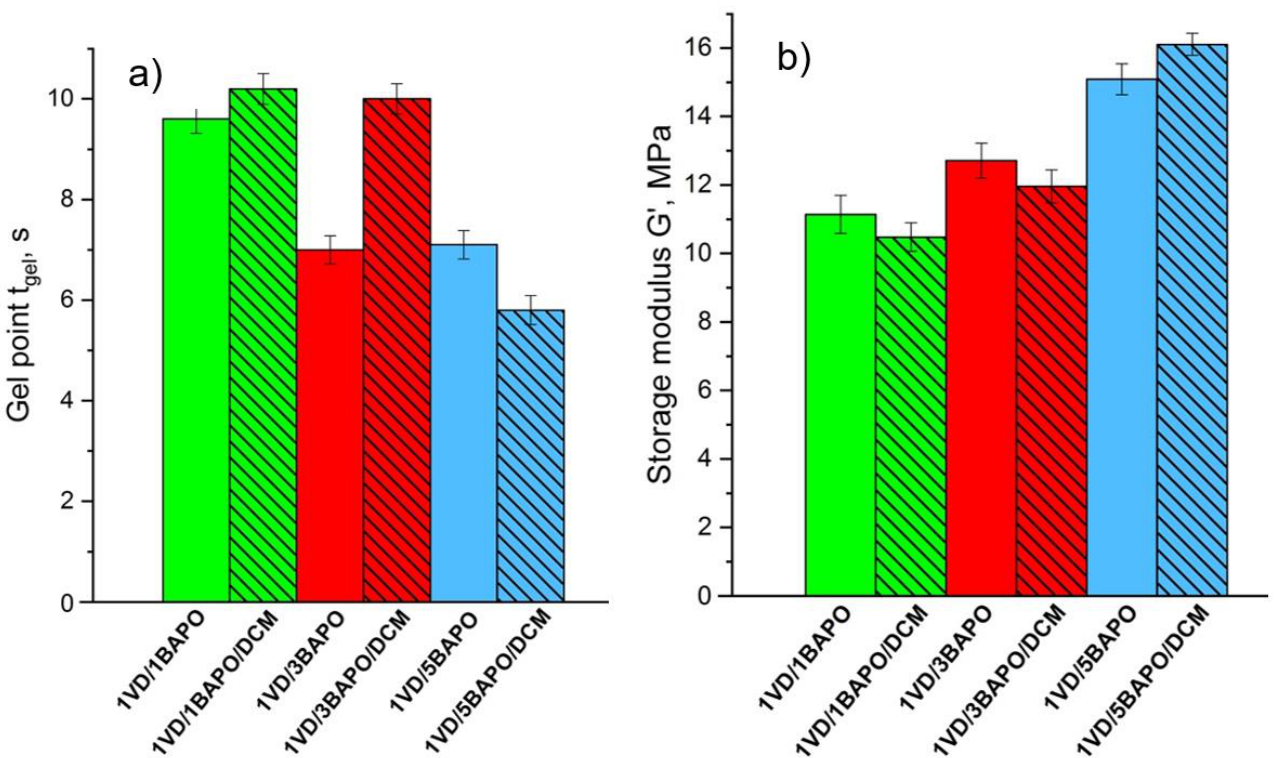
Figure 4. Gel point t gel ( a ) and storage modulus G ’ ( b ) of the VD-based resins. Green columns—1 mol% of BAPO; red columns—3 mol% of BAPO; blue columns—5 mol% of BAPO; leaning lines from top to bottom—presence of DCM.